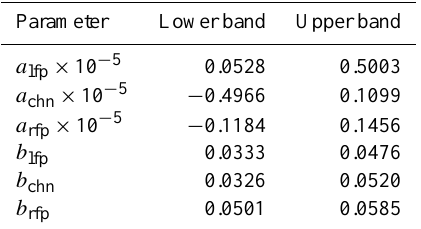
Table 1. Parameter ranges used in Monte Carlo simulations;